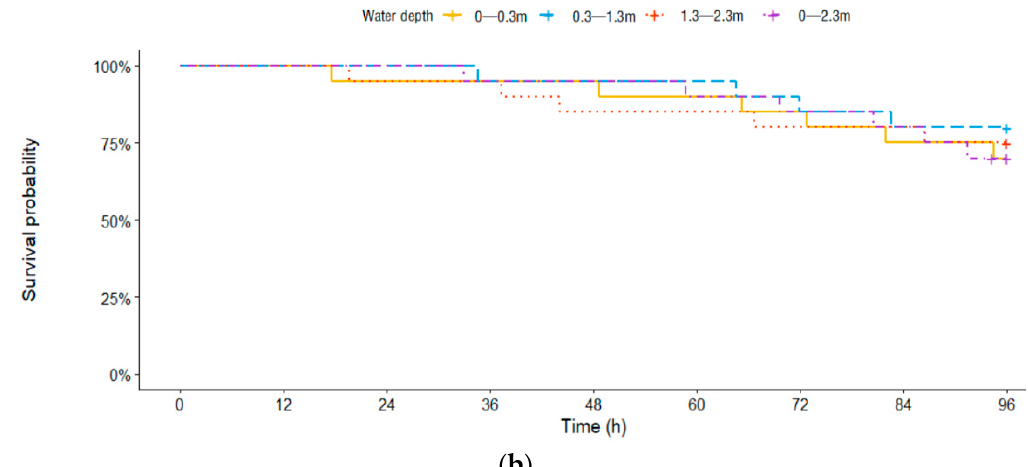
Figure 3. Survival curves of the test fish under total dissolved gas (TDG) supersaturation (116%) at different water depths (0–0.3 m, 0.3–1.3 m, 1.3–2.3 m and 0–2.3 m). ( a ) Procypris rabaudi ; ( b ) Myxocyprinus asiaticus . Table 2 lists the estimated parameters obtained from the AFT model fitting. The effect of water depth on the survival of juvenile Procypris rabaudi and Myxocyprinus asiaticus was estimated using the absolute values of the coefficients. The results showed that water depth had a strong effect on the survival of juvenile Procypris rabaudi exposed to TDG supersaturation. Compared with shallow water (0–0.3 m), deep water significantly increased the survival of juvenile Procypris rabaudi (|Coeff. β 0.3 − 1.3 m | = 0.63, p = 0.05 and